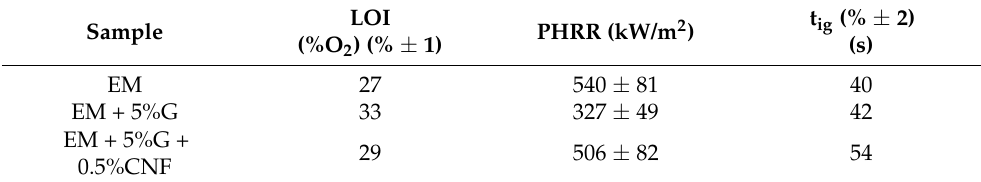
Table 1. LOI, PHRR, and Time-to-Ignition (t i ) values of the investigated